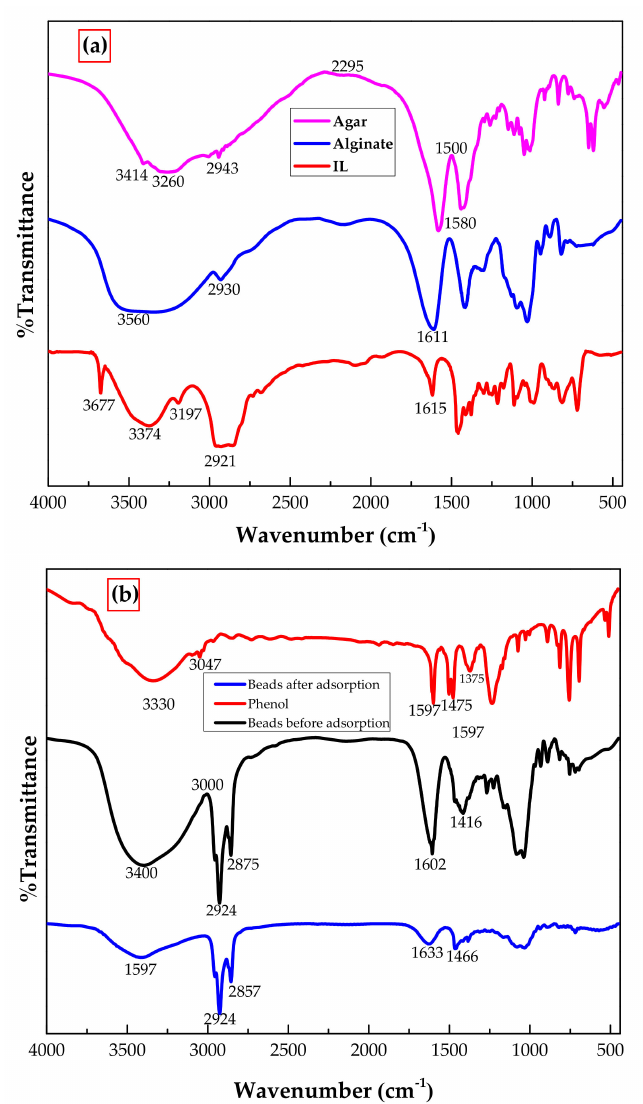
Figure 4. FTIR spectra of ( a ) IL, alginate and agar ( b ) Phenol and IL–agar–alginate bead before and after phenol adsorption.